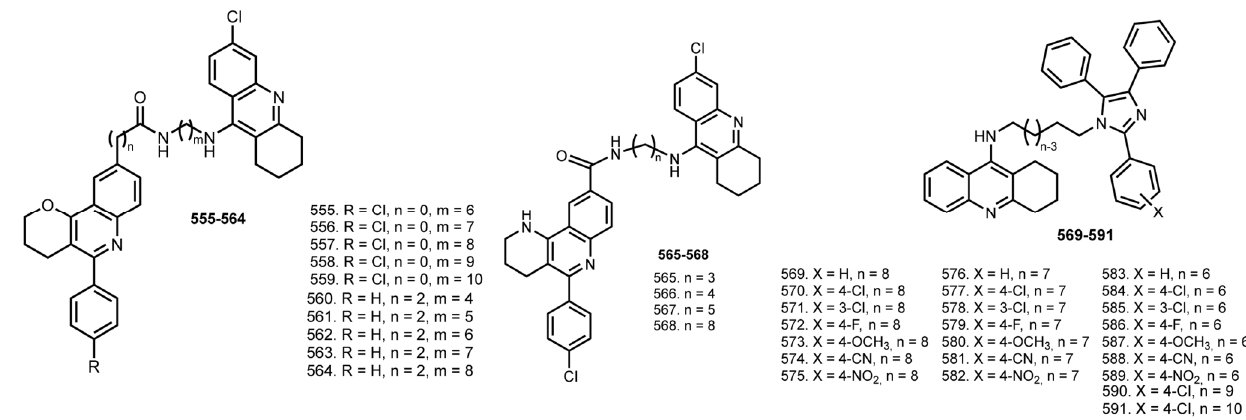
Figure 22. 6 ‐С l ‐ THA ‐ 5 ‐ phenylpyrano [3,2 ‐ c]quinoline hybrids 555 – 564 [91], 6 ‐С l ‐ THA–tetrahydro ‐ Figure 22. 6-Cl-THA-5-phenylpyrano [3,2-c]quinoline hybrids 555 – 564 [91], benzo[h][1,6]naphthyridine 565 – 568 [92], THA–lophine hybrids 569 – 591 [93].